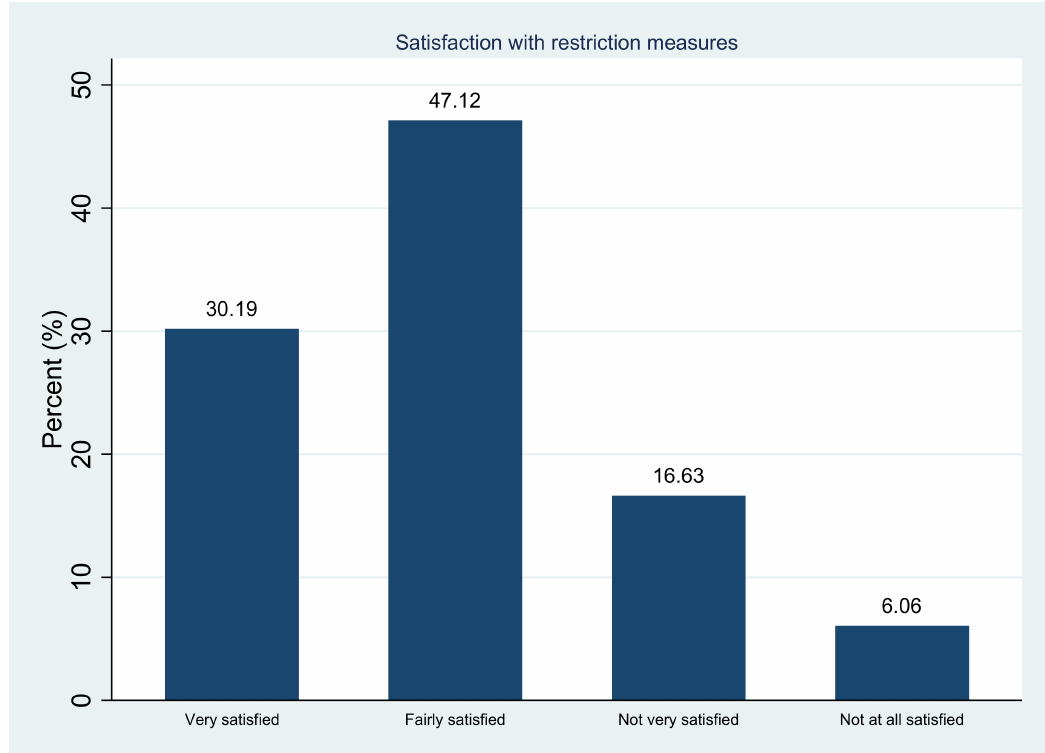
Figure 1. Satisfaction with restriction